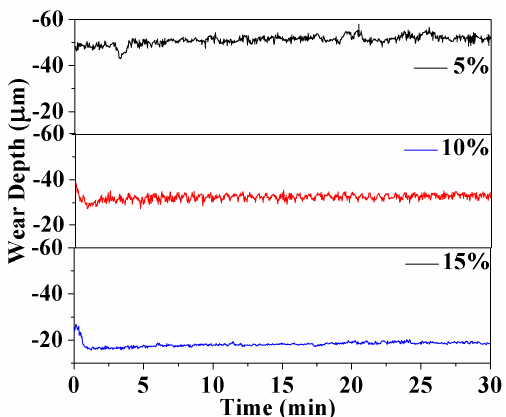
Figure 8. Wear depth of NiCr–TiB 2 –ZrB 2 coatings.